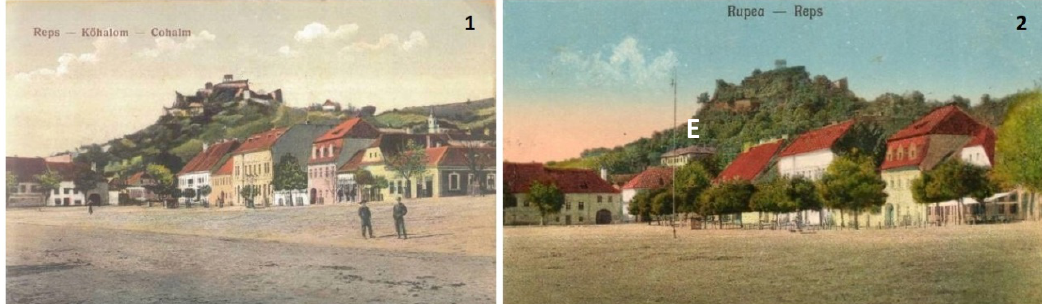
Figure 7: Postcards with view on Reps-Kőhalom-Cohalm and later Rupea in the first integration period into the Kingdom of Romania (the interwar period) 1 – cca. 1922, 2 – The first appearance of the high school building, after